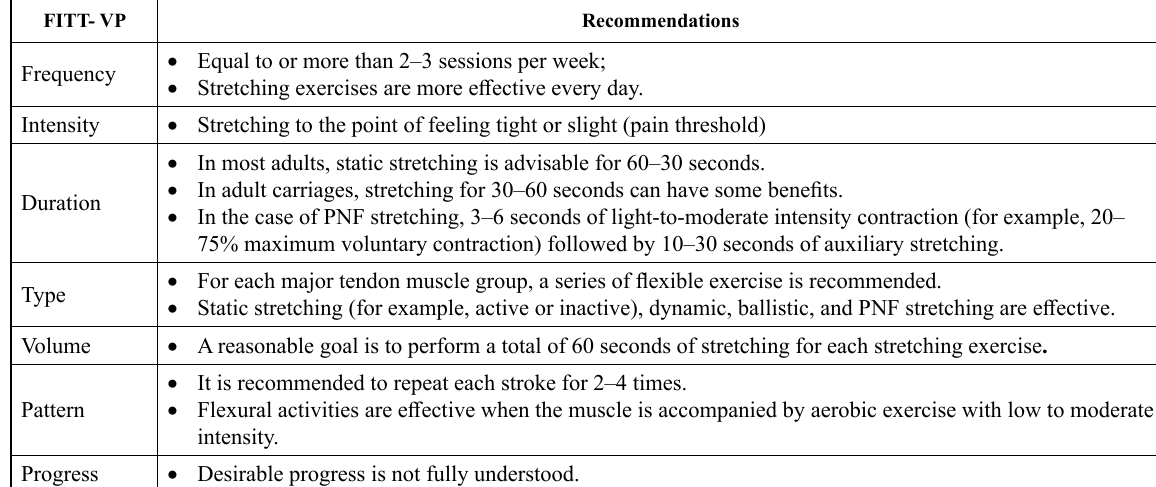
Table 5. Recommendations based on flexibility